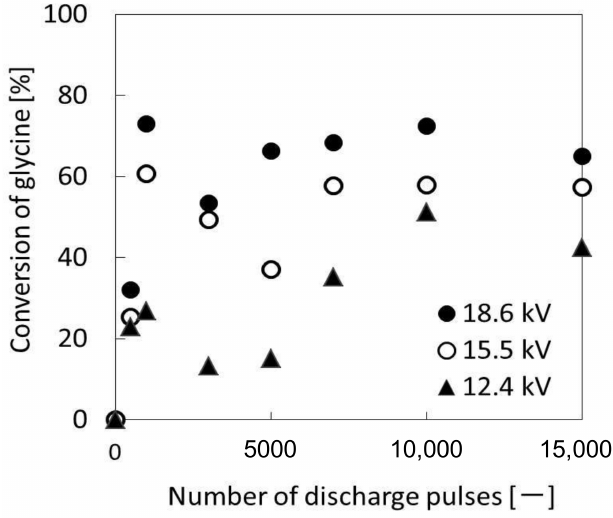
Figure 3. Conversion of glycine after treatment by pulsed discharge plasma at voltages of 12.4, 15.5 and 18.6 kV.